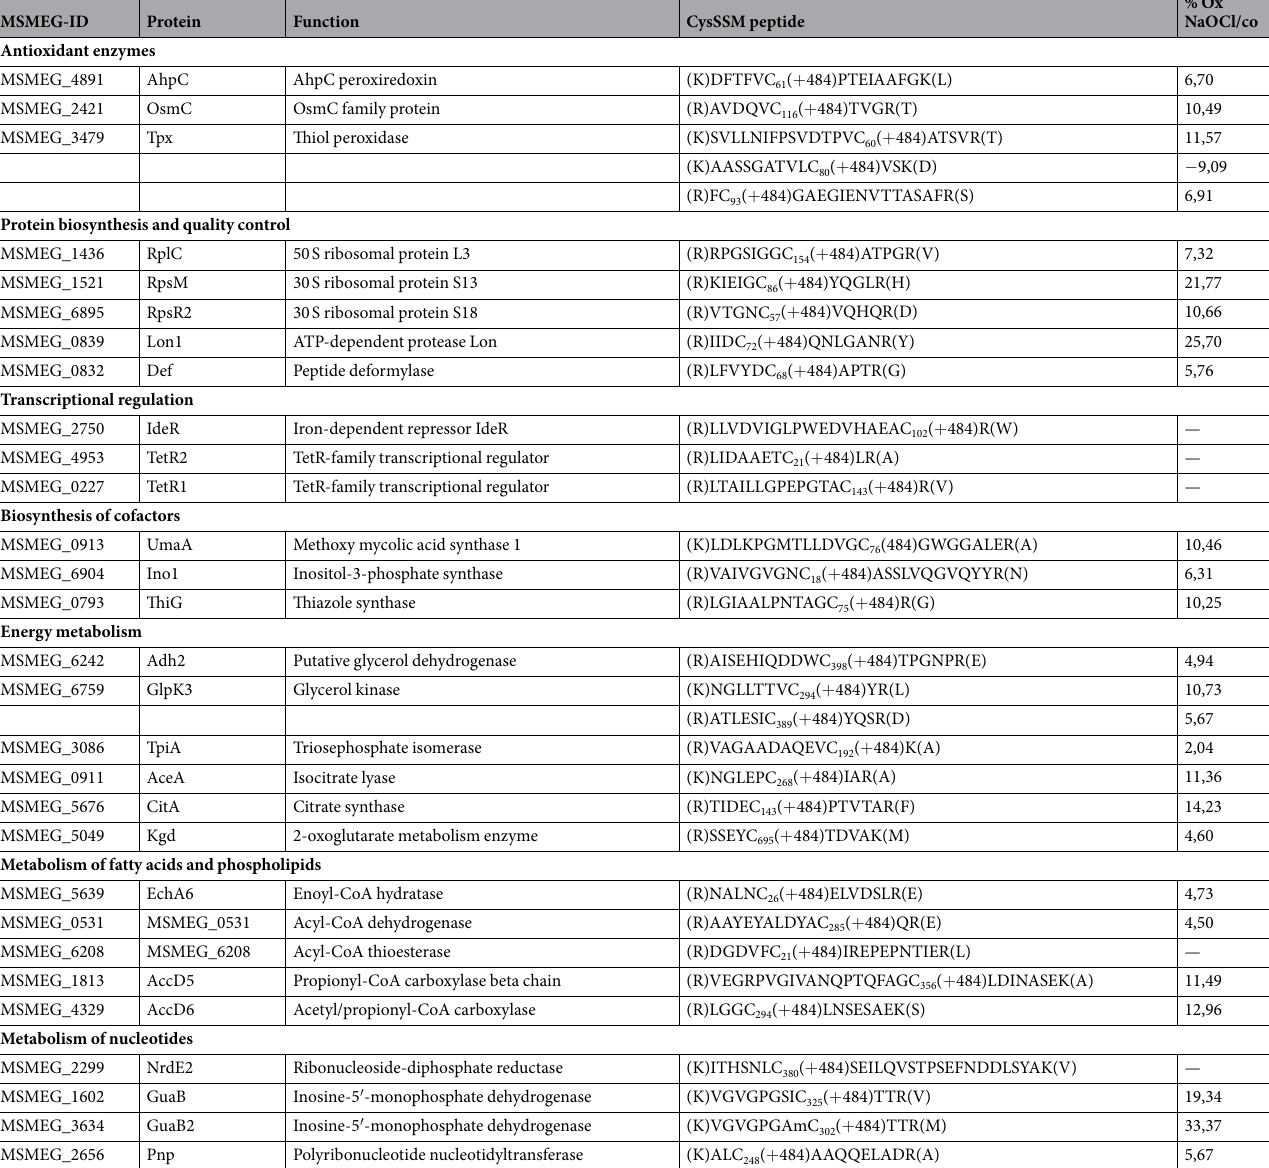
Table 1. Selected S -mycothiolated proteins of Mycobacterium smegmatis wild type and quantification of their % oxidation by OxICAT. The M . smegmatis wild type was exposed to 1 mM NaOCl for 30 min and 58 S - mycothiolated proteins were identified using shotgun LC-MS/MS analysis using the Scaffold proteome software based on the mass increase of 484 Da ( + MSH) at Cys peptides. The table lists for 29 selected mycothiolated proteins the MSMEG-ID, the protein name, function and the S-thiolated Cys peptide sequence. The OxICAT data were extracted from Tables S3 and S4 for the S -mycothiolated Cys peptides. The full table of the 58 S - mycothiolated proteins is presented in Table